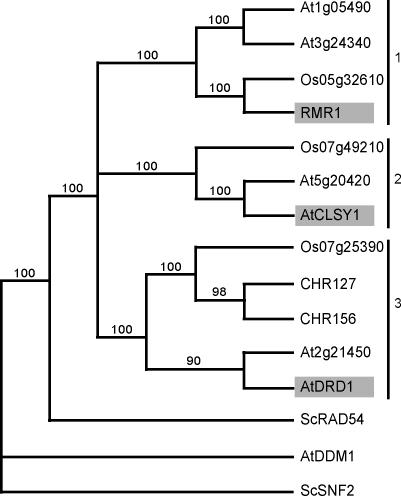
RMR1 Defines a Monophyletic Clade Distinct from DRD1Distance tree with bootstrap values produced from alignment (Figure S2) of the predicted Snf2 domain with other Snf2 proteins: the tree shows that RMR1, CLSY1, and DRD1 (highlighted in gray) are members of a Rad54-like subfamily of Snf2 proteins. Three distinct monophyletic groups compose this subfamily, numbered 1 to 3. Prefixes: At, Arabidopsis; Os, rice; Sc, S. cerevisiae.